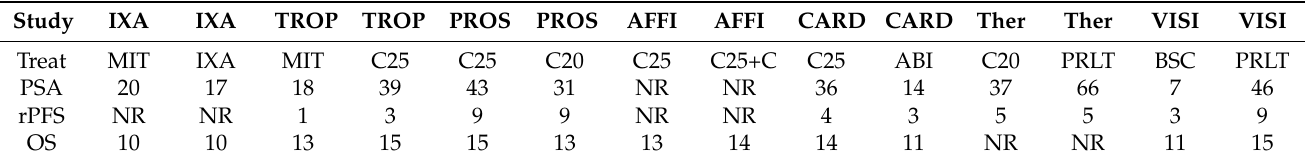
Table 2. Outcomes.